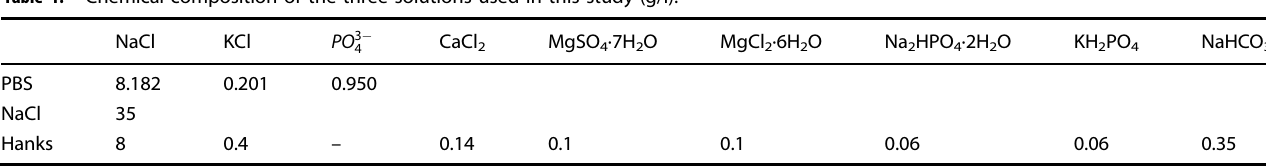
Table 1. Chemical composition of the three solutions used in this study